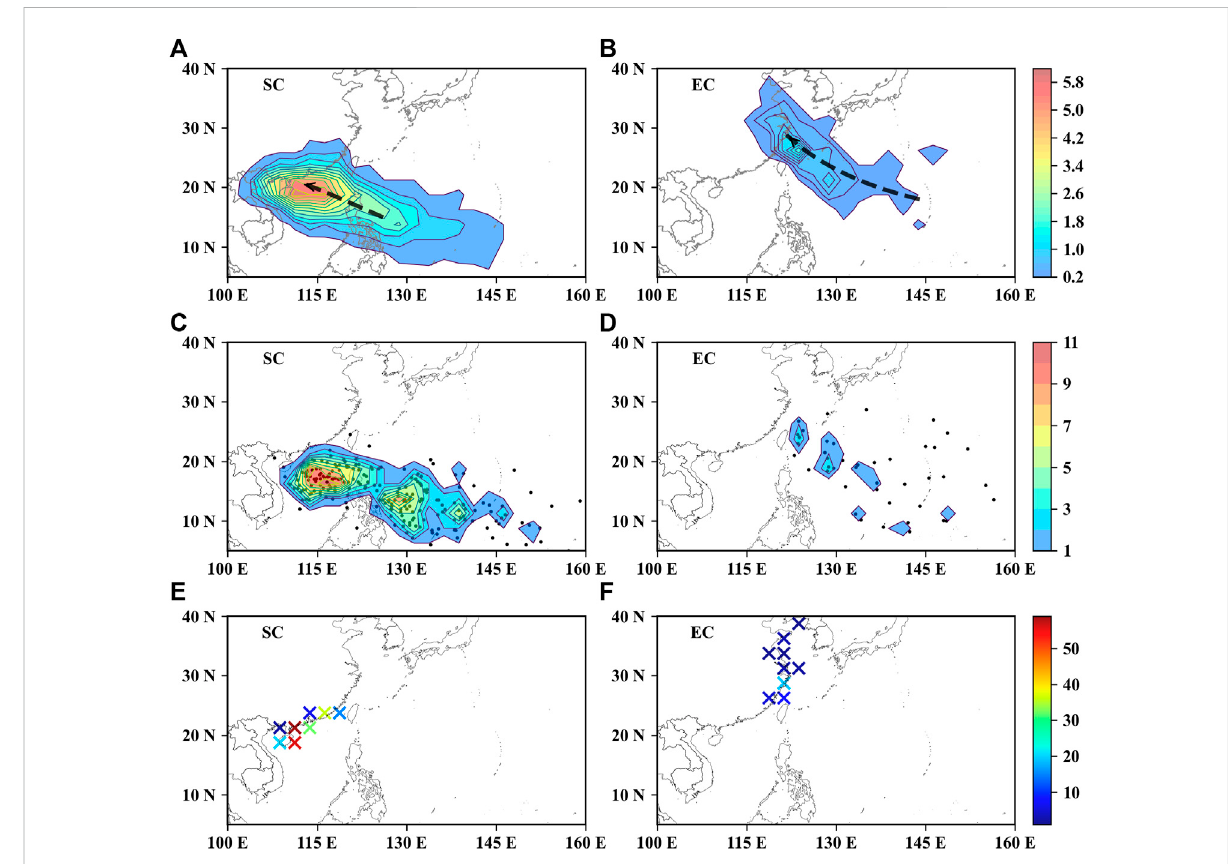
FIGURE 1 Frequency distribution of (A,B) annual mean TC occurrence, (C,D) TC formation, and (E,F) TC landfall over a grid of 2 . 5 ° × 2 . 5 ° during the TC peak season (Jul – Oct) from 1980 to 2020. The thick dashed curves with arrows in (A,B) schematically denote the mean regression trajectories of landfalling TCs, and the markers ‘ . ’ in (C,D) indicate TC genesis locations. The left column is for TCs landfalling in SC and the right column is for TCs landfalling in